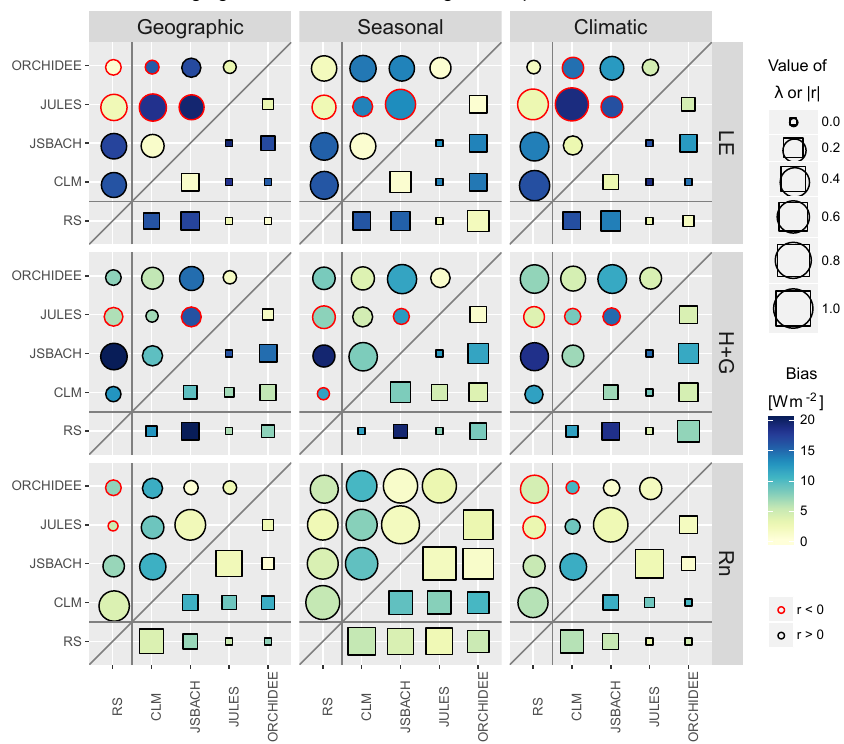
Figure 5. Summary of the agreement between land surface models amongst themselves and with the remote sensing estimations for the vegetation transition from evergreen broadleaf trees to crops ( Crops – EvgTr ). The agreement is measured using the index of agreement λ (size of the squares), the Pearson correlation coefficient r (size of the circles, red border indicates negative correlation) and the absolute bias (colour of the symbols). The data used to calculate these metrics are the values previously averaged in bins according to the spatial, seasonal and climatic analysis spaces shown in Fig. 2. Hence, these metrics relate only to areas where both vegetation types locally co-exist in reality. The fluxes represented are net radiation (Rn), latent heat flux (LE), and the combination of the sensible and ground heat fluxes (H +